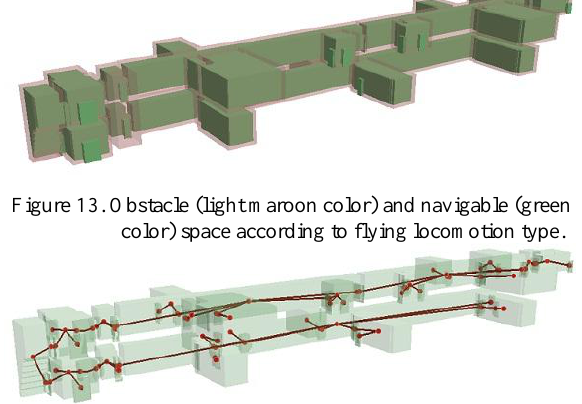
Figure 14. Navigable space according to flying locomotion type (space, state, and transition